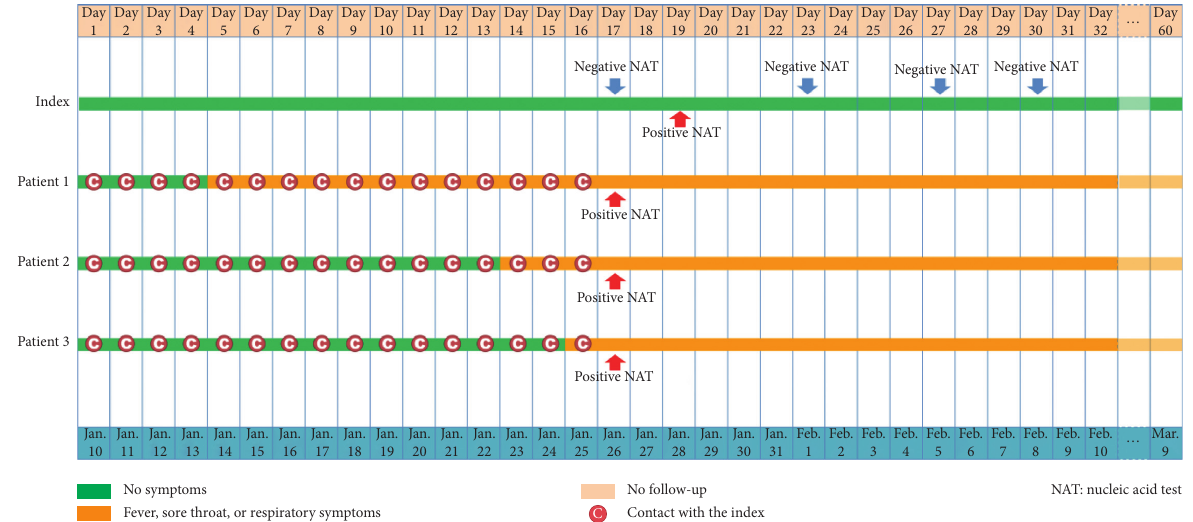
Figure 1: Timeline of exposure to the asymptomatic index with COVID-19 infection in Anyang, Henan, China.